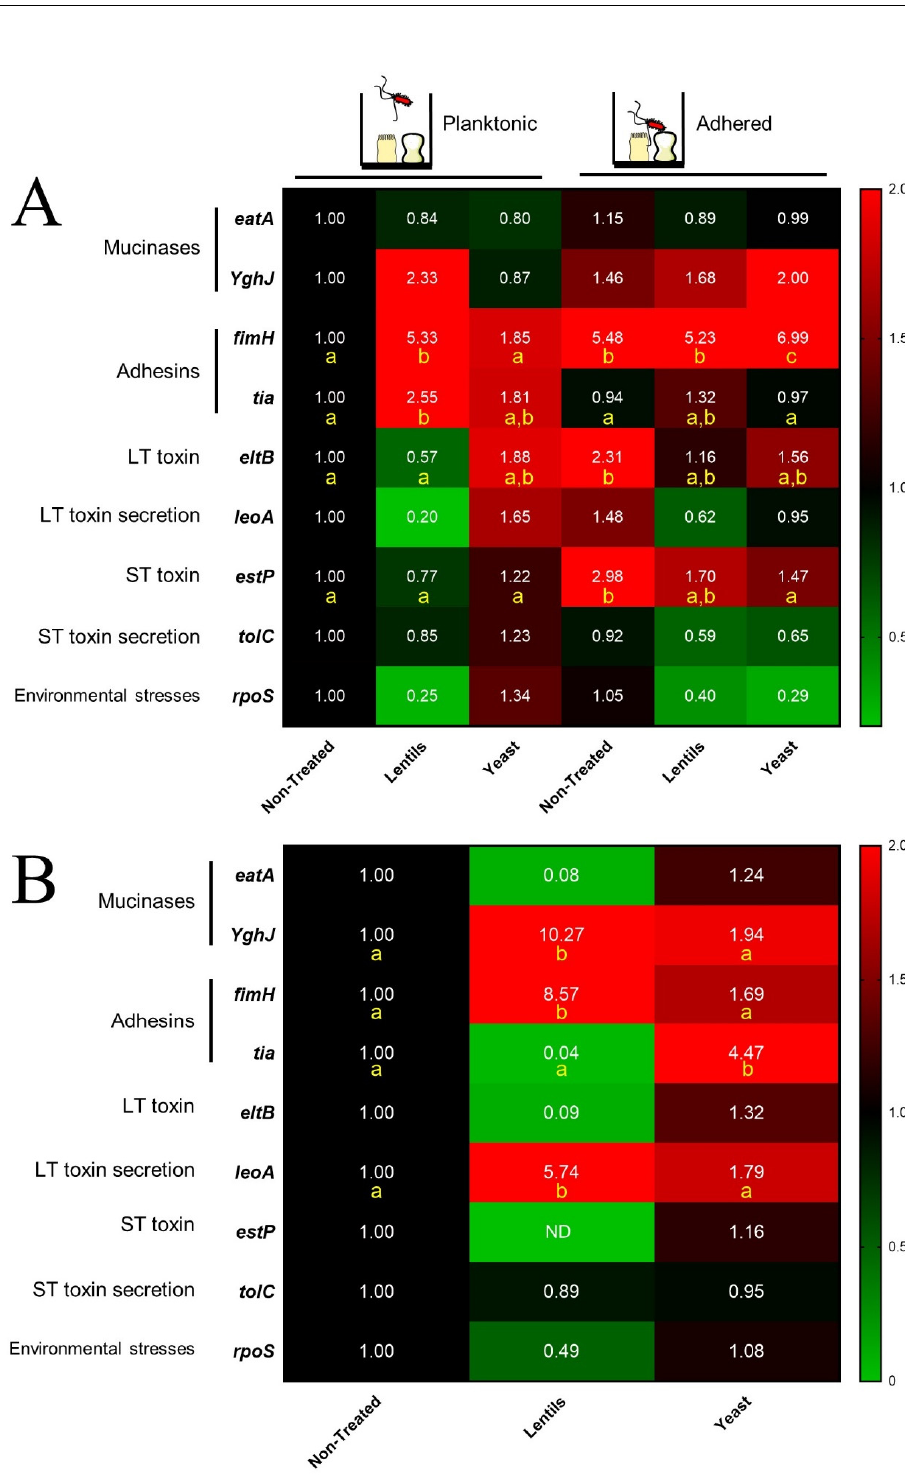
Figure 4. Impact of fiber-containing products on virulence gene expression of planktonic and adherent ETEC cells. ETEC virulence gene expression was analyzed by RT-qPCR in Caco2/HT29-MTX cells infected at MOI 100 ( A ) or in DMEM medium as a control condition devoid of intestinal cells ( B ), with or without lentil extract (‘lentils’) and specific yeast cell walls (‘yeast’) at a final concentration of 2 g · L − 1 . Results are expressed and colored according to fold-change expression compared to the control condition (planktonic bacteria non-treated in ( A ) and non-treated medium in ( B )). Figure represents at least three independent experiments. If a statistical difference was reached, results that are significantly different from each other according to Tukey’s multiple comparisons tests are grouped under different yellow letters ( p < 0.05). NT = non-treated, ND =